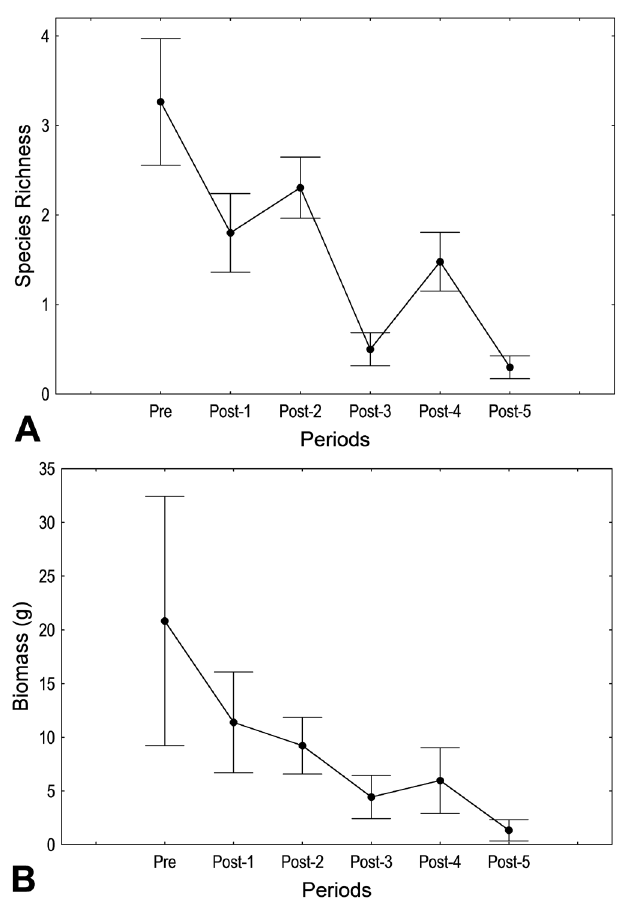
FIGURE 1 | Species richness ( A ) and total biomass ( B ) in fish assemblages associated with macrophyte beds in Rosana Reservoir, before (Pre) and after (Post 1 to 5) the introduction of Cichla kelberi . Mean ± standard error.